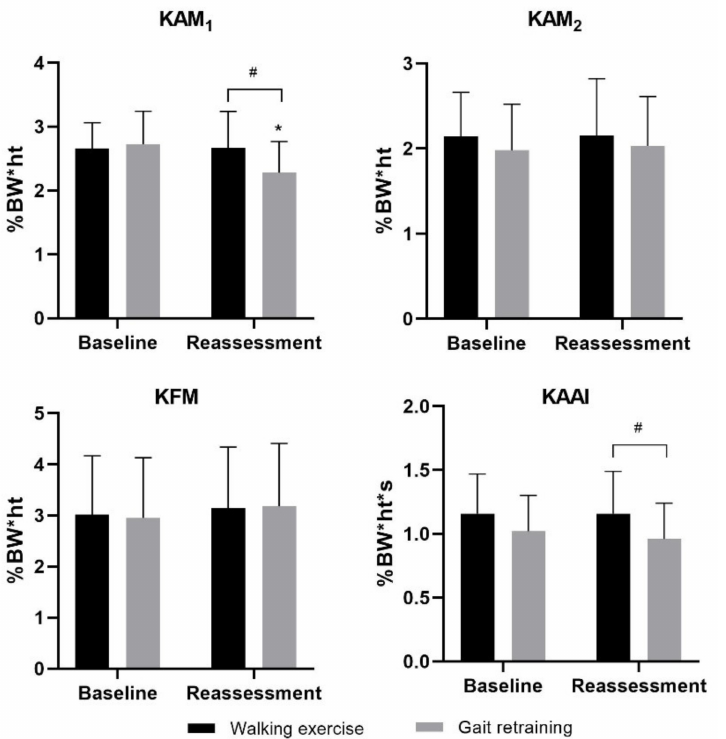
Figure 4. Effects of gait retraining on biomechanical outcomes (KAM, KFM and KAAI). Error bars indicate standard deviations. * indicates significant within-group difference between post- and pre-training score. # indicates significant between-group difference at certain time point.